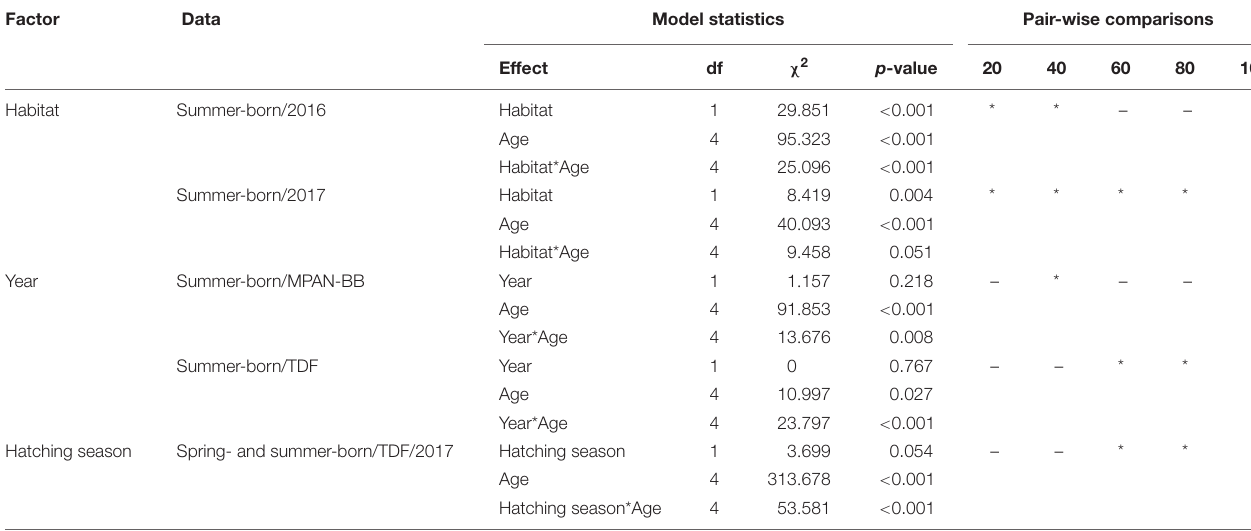
TABLE 3 | Results of repeated measure analyses of otolith increment widths at 20, 40, 60, 80, and 100 days of age of Fuegian sprats Sprattus fuegensis in the Marine Protected Area Namuncurá-Burdwood Bank (MPAN-BB) and Tierra del Fuego (TDF). Factor Data